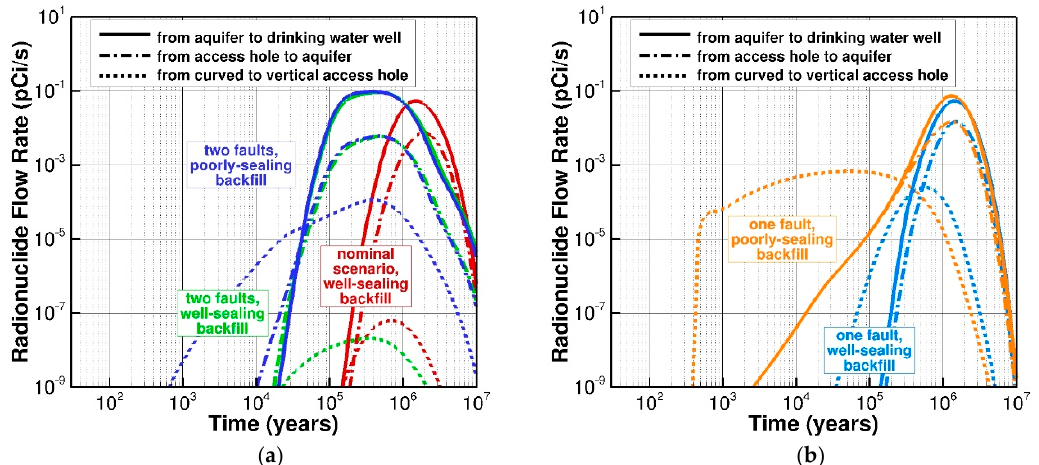
Figure 11. 129 I activity flow rates along vertical access hole with sealing and poorly ‐ sealing backfill for ( a ) reference and two ‐ fault scenario, and ( b ) one ‐ fault scenario.